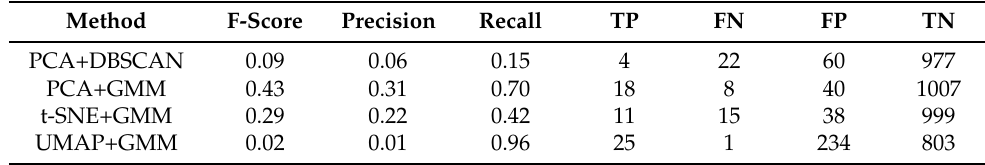
Table 4. Experiment results for Dataset 1 where ANCs are NOT considered as True